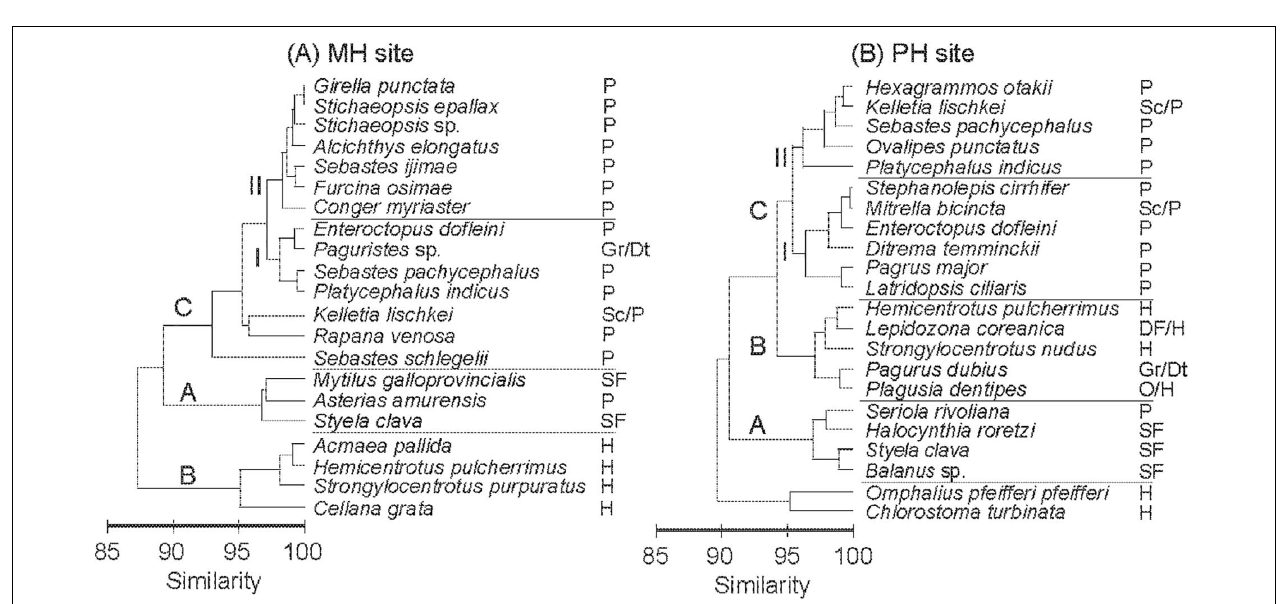
FIGURE 3 | Relationship between (A) δ 13 C – total weight and (B) δ 15 N – total weight of Enteroctopus dofleini collected from the marine ranches (empty circle, MH site; filled circle, PH site). Dashed lines represent the relationship according to linear regression. The regression coefficients ( r 2 ) were − 0.091 and 0.118 for δ 13 C and δ 15 N values, respectively.